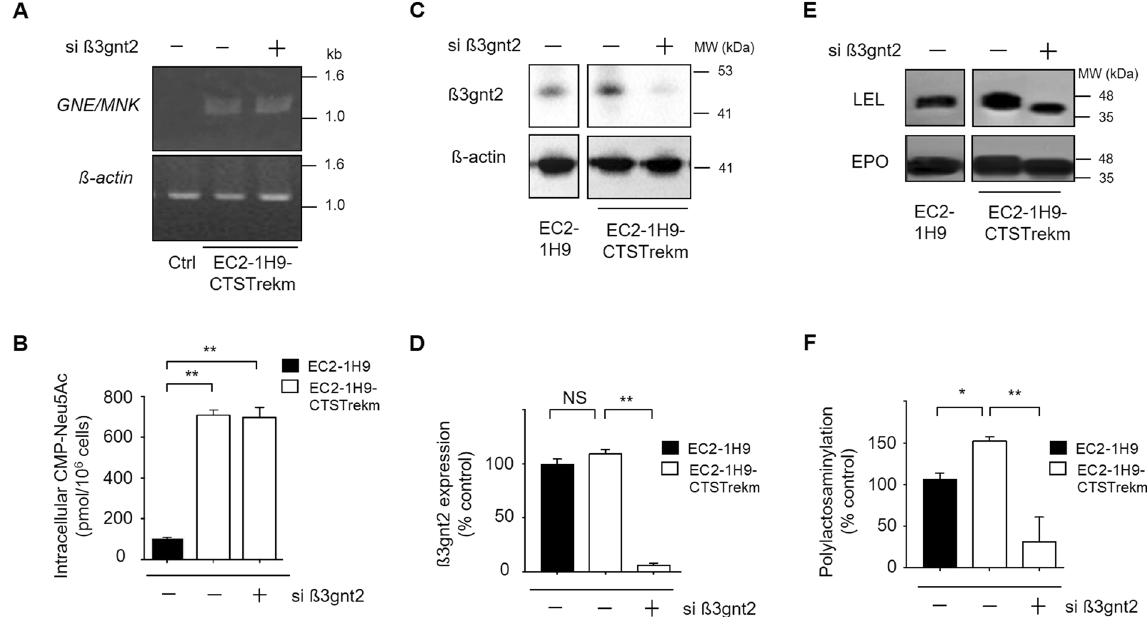
Figure 4. Poly-LacNAc is reduced in CHO cells with high intracellular CMP-Neu5Ac. ( A ) The over-expression of GNE in EC2-1H9-CTSTrekm9 confirmed by RT-PCR. Lane 1, EC2-1H9 cells; Lane 2, EC2-1H9-CTSTrekm cells; Lane 3, EC2-1H9-CTSTrekm cells treated with β 3gnt2 -specific siRNAs. ( B ) Bypassing CMP-Neu5Ac feedback inhibition via GNE over-expression increases intracellular CMP-Neu5Ac. ( C ) Expression of β 3gnt2 was examined in EC2-1H9-CTSTrekm cells with depletion of β 3gnt2 using siRNA. Lane 1, EC2-1H9 cells. Lane 2, EC2-1H9-CTSTrekm cells. Lane 3, EC2-1H9-CTSTrekm cells treated with siRNA against β 3gnt2. ( D ) Quantification of panel C was shown. The band intensities of β 3gnt2 were normalized by the intensities of β -actin. ( E ) Polylactosaminylation of purified rhEPO measured by western blot using LEL. For detection of polylactosaminylation, 1 μ g of purified rhEPO was used. ( F ) Quantification of the data in C. The LEL lectin band intensity was normalized by the EPO band intensity. The data shown are presented as means ± S.E.M. from three independent experiments each with duplicate samples. ** P < 0.01, * P < 0.05 (Student’s